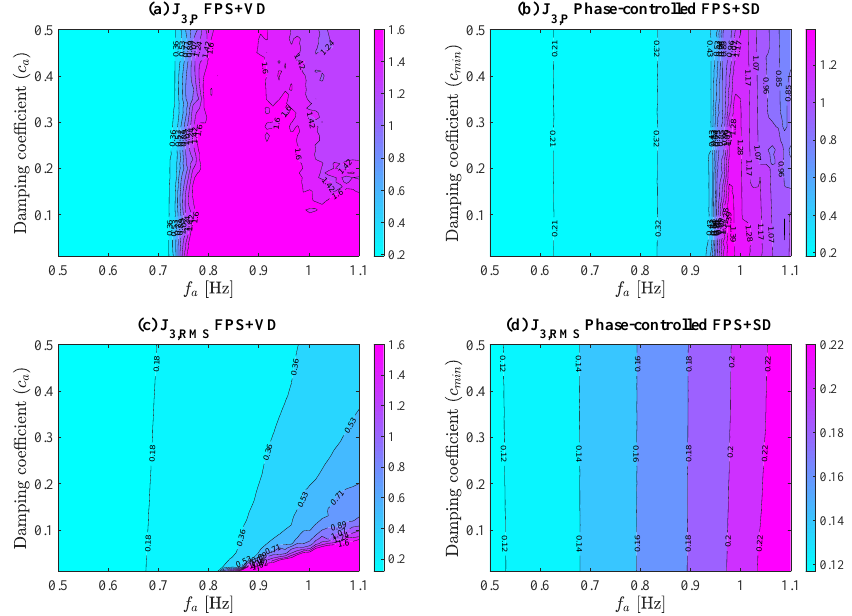
Figure 11. J 3 for FPS+VD and phase-controlled FPS+SD under the design